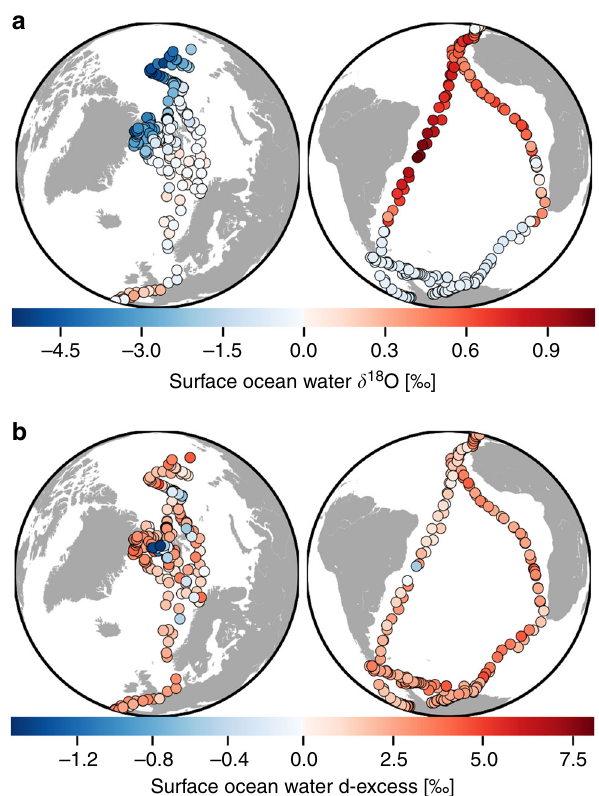
Fig. 2 Isotopic composition of surface ocean water during the period 29 June 2015 to 30 June 2017. The maps show the different measurement locations of surface ocean water from daily taken samples, with colours indicating the measured δ 18 O and d-excess values in ‰ , for panels a and b , respectively